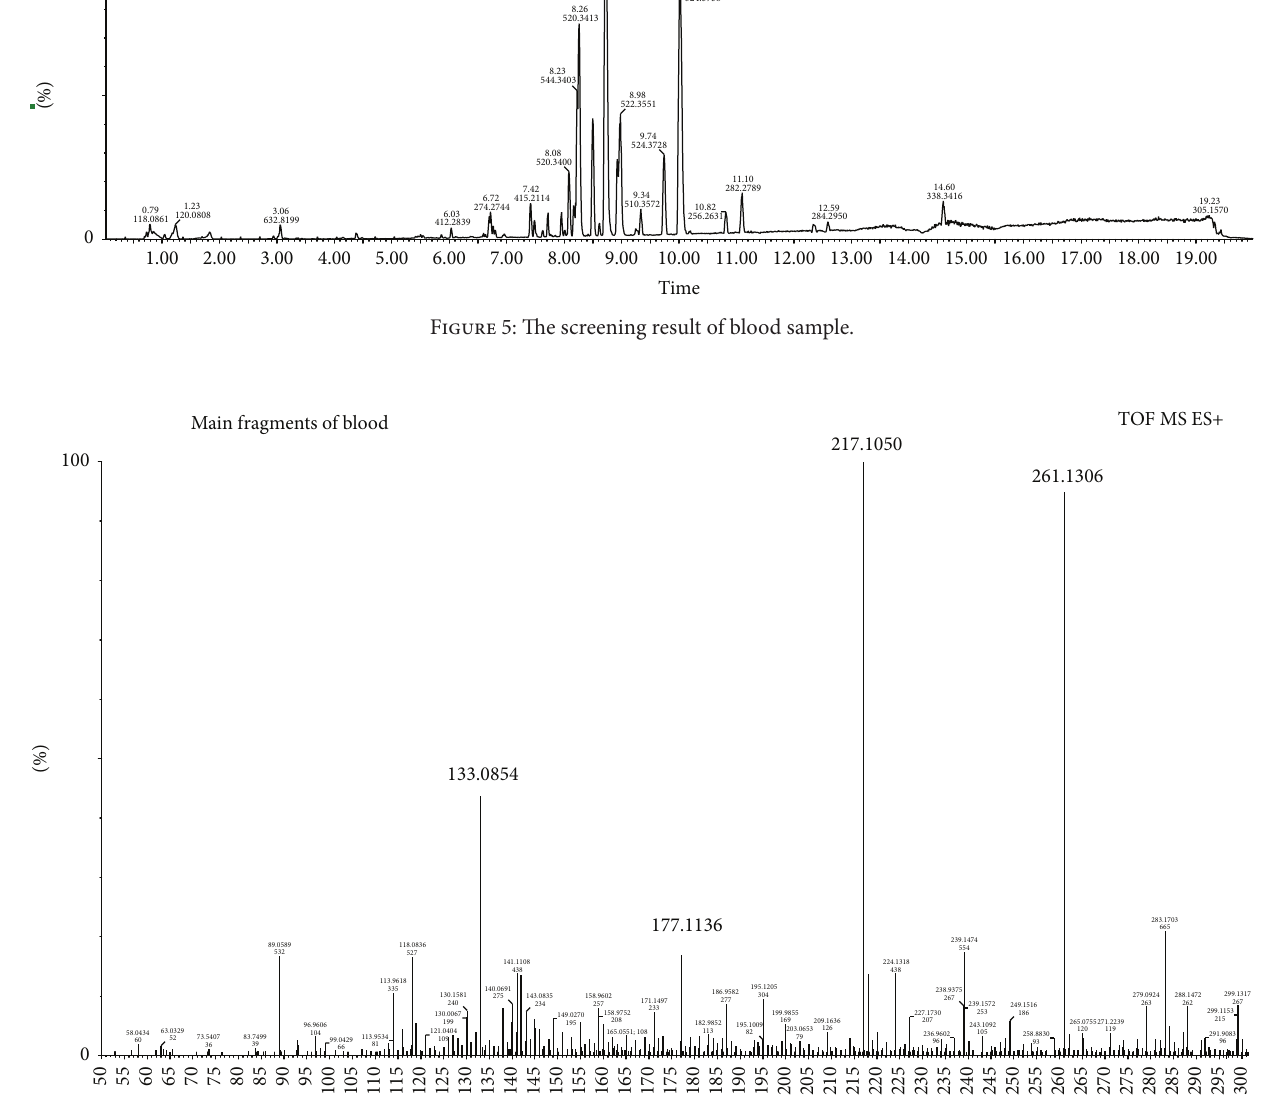
Figure 6: The main fragments of screening from